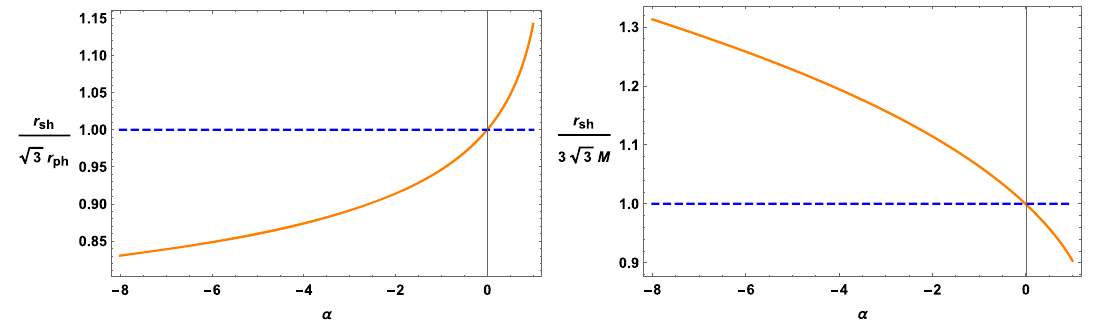
Fig. 4 the dependence of r sh √